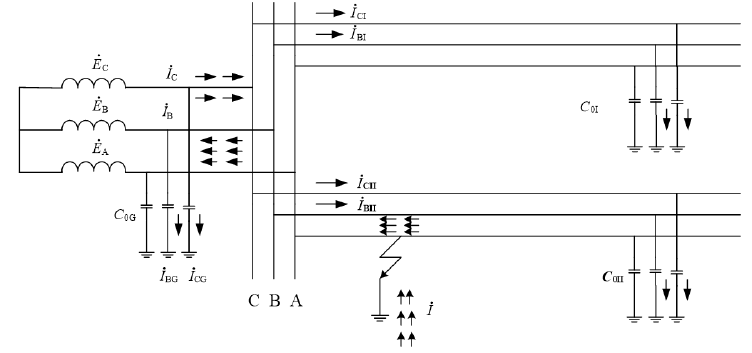
Figure 1. Capacitor current distribution diagram.